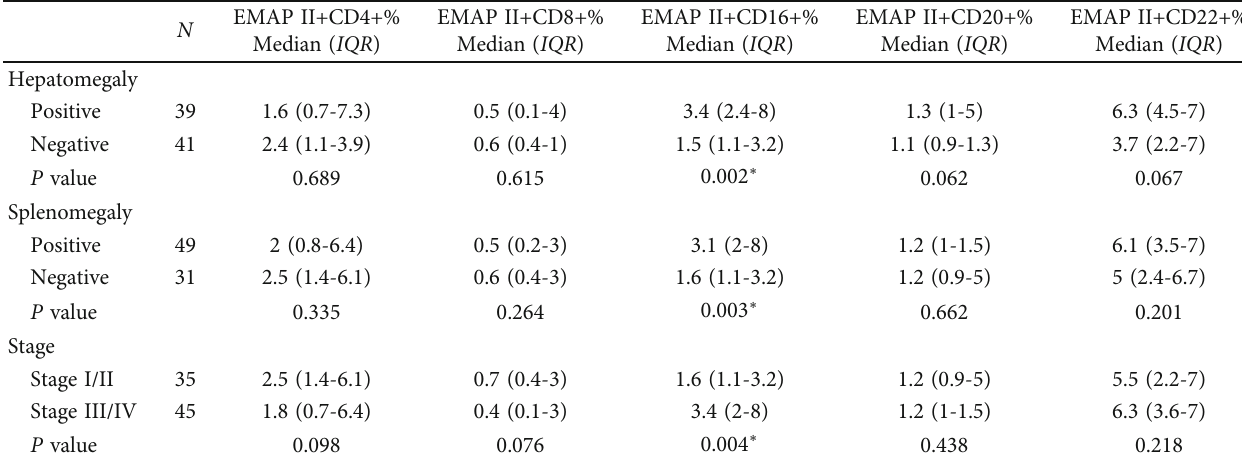
Table 4: Correlation between percentages of EMAP II+CD4+, EMAP II+CD8+, EMAP II+CD16+, EMAP II+CD20+, and EMAP II+CD22 + and clinical characteristics of NHL patients.